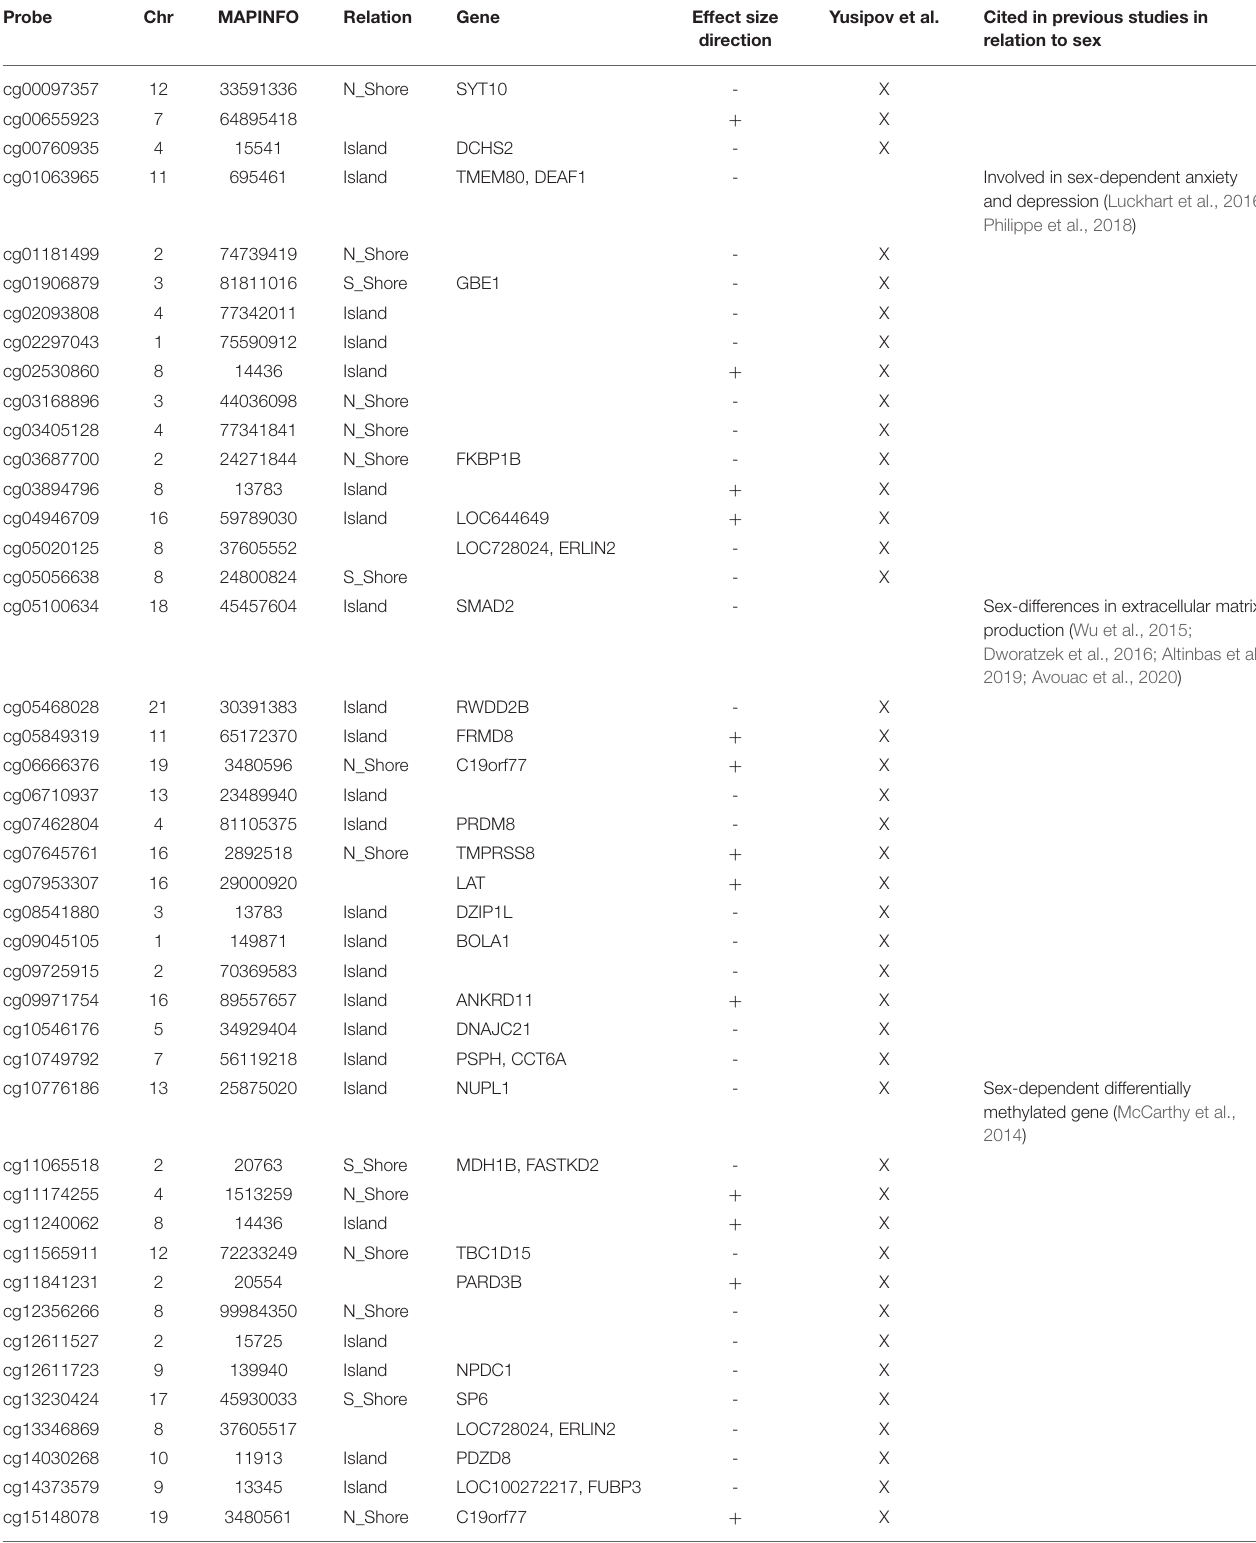
TABLE 3 | sDMPs resulting from cross-region analysis.